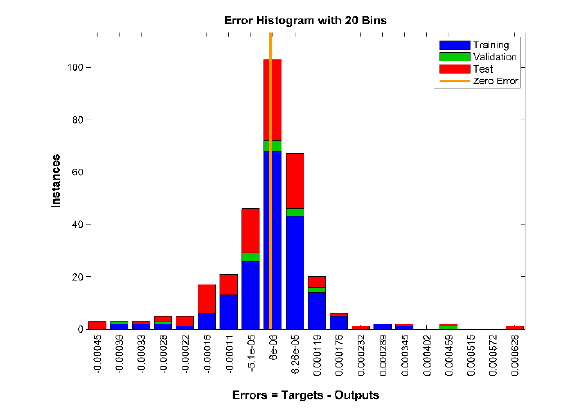
Figure 4. Error Histogram for the ANN outputs (Lane 1)